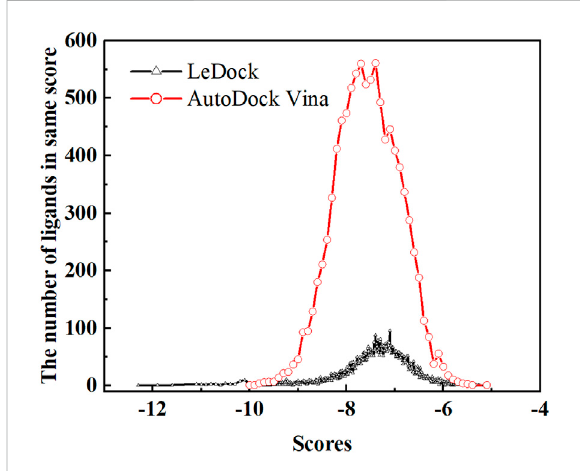
FIGURE 4 InLeDockandAutoDockVina,thenumberofligandswiththe same